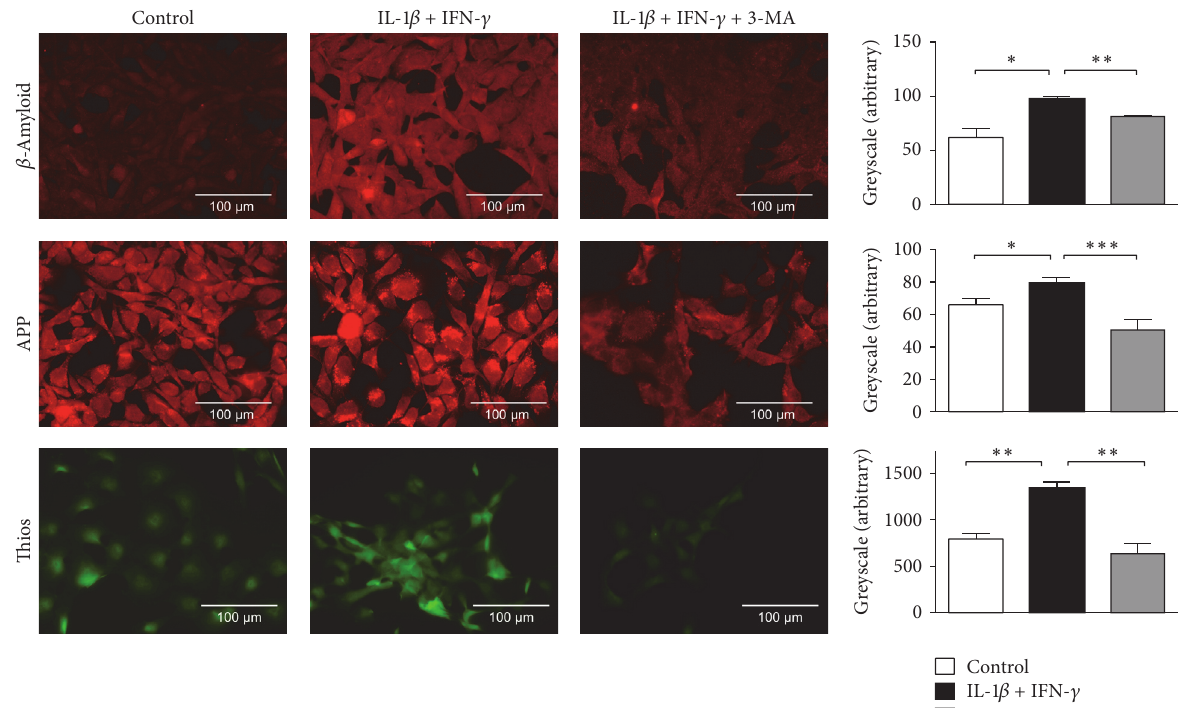
Figure2:Autophagy-associatedupregulationof 𝛽 -amyloidandAPP.Immunocytochemicalanalysisofhumanmyoblastswhichwereexposed to IL-1 𝛽 and IFN- 𝛾 for 48 hours displayed increased signals of thioflavin-S, 𝛽 -amyloid, and APP. This was reversed after inhibition of autophagy via 3-MA. Quantitative greyscale analysis was performed using Image J and results are shown as standard error of mean of three independent experiments. ∗ 𝑝 < 0.05 , ∗∗ 𝑝 < 0.01 , and ∗∗∗ 𝑝 < 0.001 .